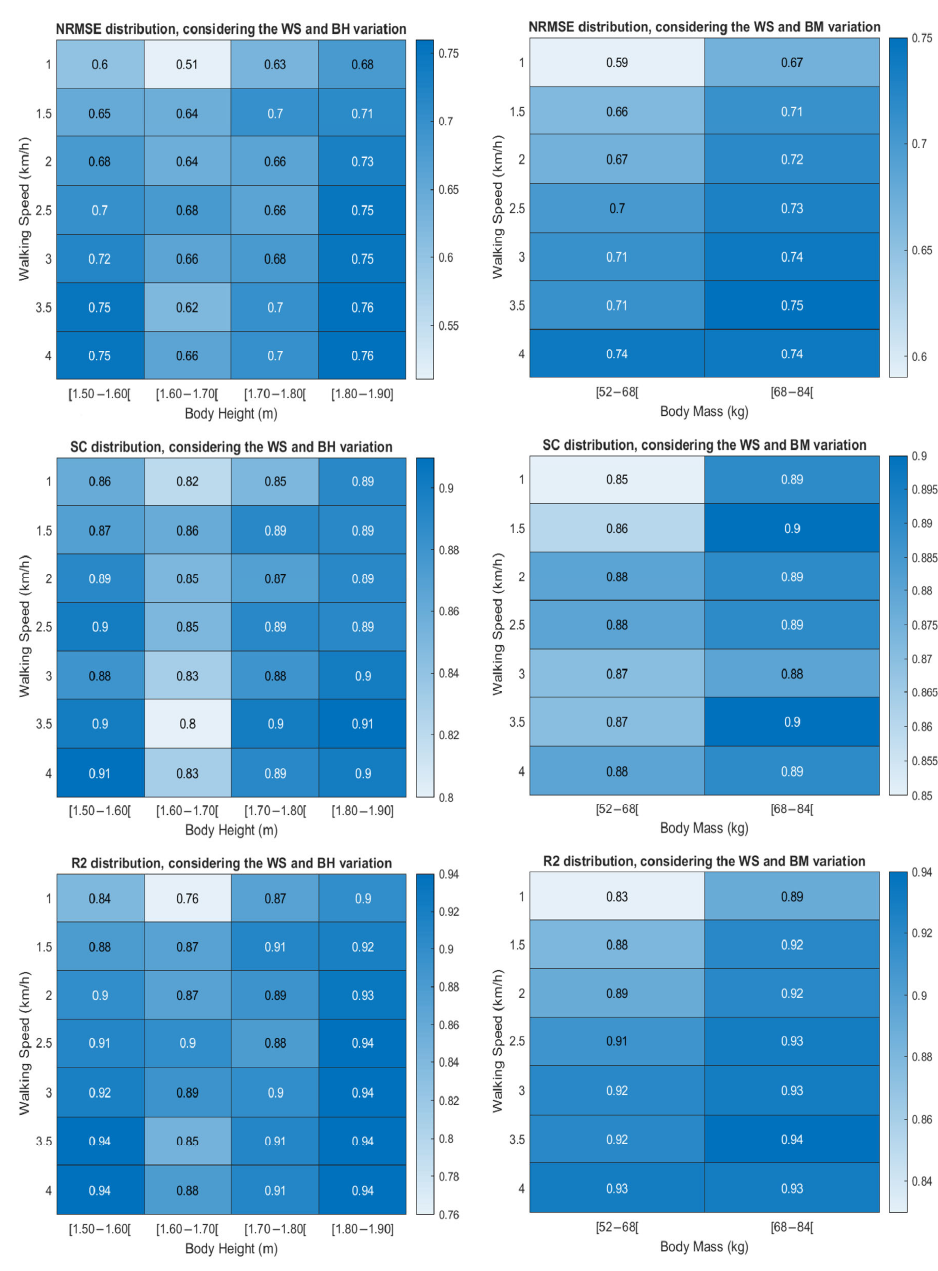
Figure 5. NRMSE, SC, and R 2 distribution considering the walking speed (WS) and body height (BH) variation ( left ), and the WS and body mass (BM) variation ( right ).